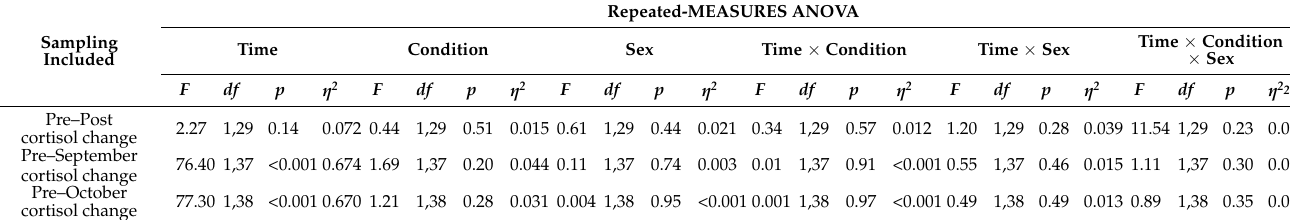
Table A1. Possible differences in the time of cortisol sampling.